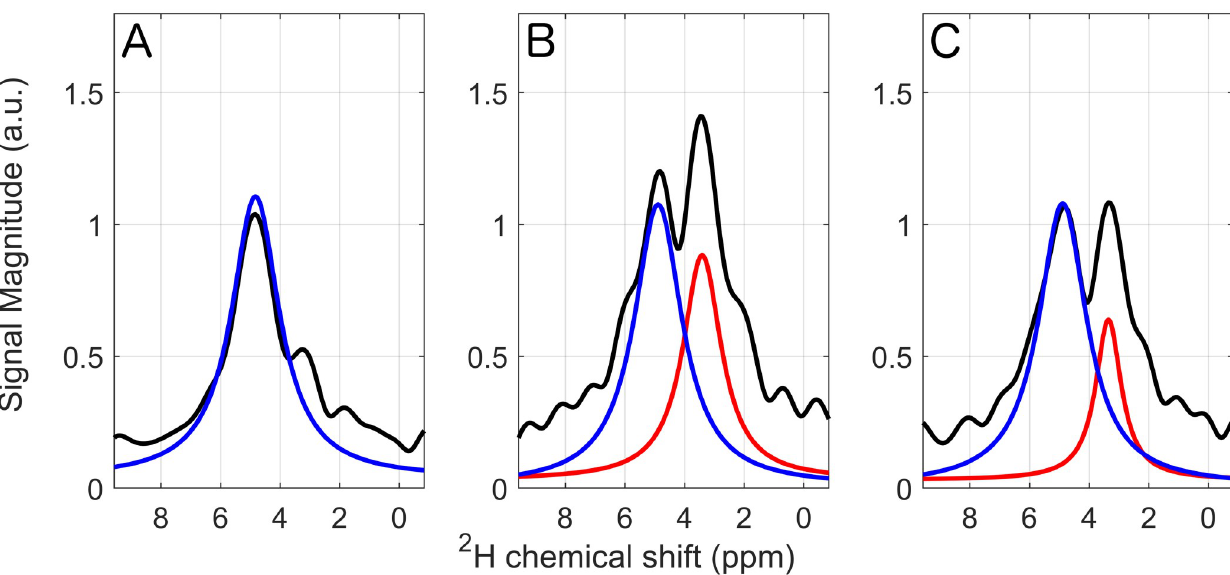
Fig 2. Deuterium spectra of rat 3 at different time points. Mono-Lorentzian functions were used to separately fit the different peaks. The water peak serves as internal reference and was set to 4.8 ppm. A Before the injection. The natural abundant deuterium in water is visible. B 170 s after the injection. The water and OMG signals are visible. C 55 minutes after the injection. Both peaks are visible, but the OMG signal shows a decreased amplitude.